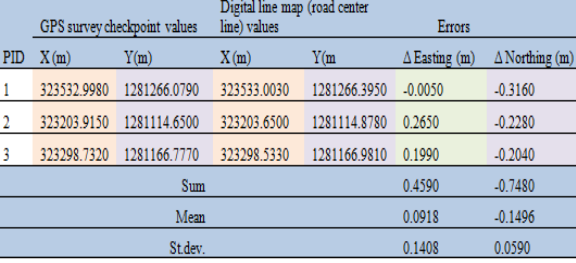
Table 6. Point wise comparative result between digital line map (road centreline) values and GPS survey checkpoint values in road